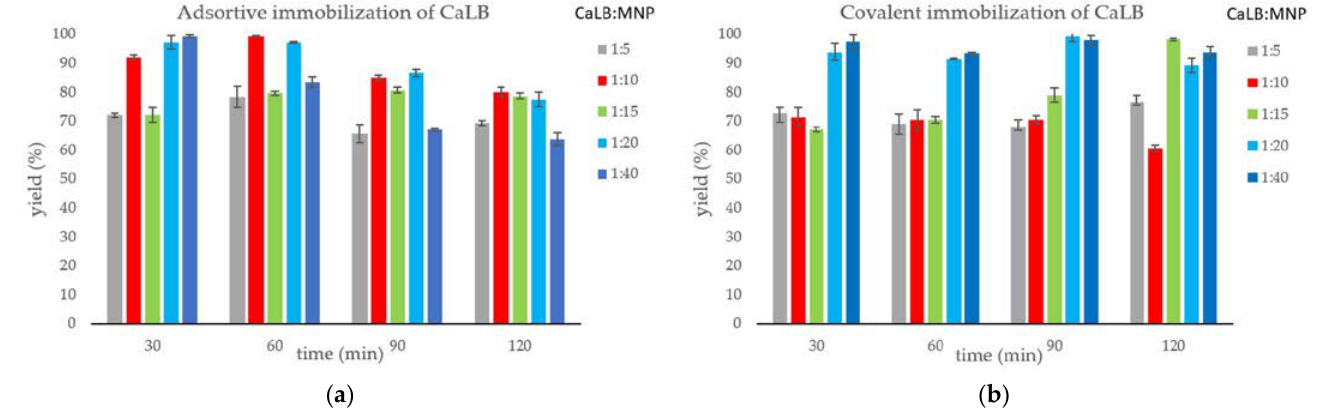
Figure 2. Immobilization yields for lipase B from Candida antarctica (CaLB) on MNPs at a different CaLB:MNP ratio (between 1:5 and 1:40) after various immobilization times (5 mg mL −1 MNP carrier, CaLB (8.0, 4.0, 2.66, 2.0, 1.0 mg mL −1 ), in sodium phosphate buffer (pH 7.5, 100 mM) at room temperature). The differently colored bars in the two charts show data of experiments ( a ) for adsorption immobilization, with MNPs etched by hexadecyl functions (HdTMOS) resulting in CaLB-MNP An , and ( b ) for covalent binding onto MNPs etched by ApDMOMS:HdTMOS (1:16) and further activated with NGDE, resulting in CaLB-MNP Cm (where n = 5–40 and m = 5–40 reflect to the CaLB:MNP mass ratio applied).